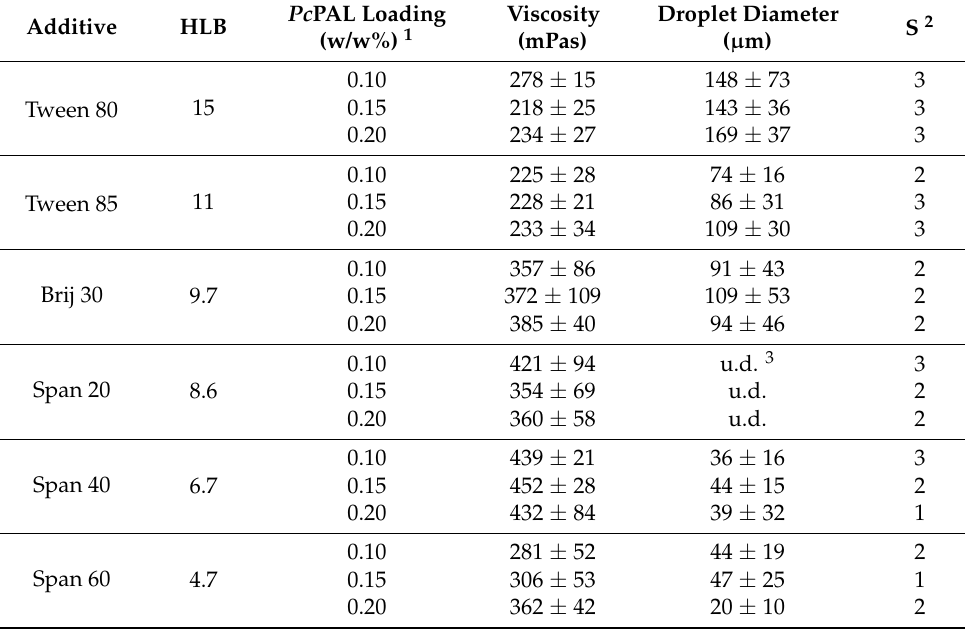
Table 2. The effect of the emulsifiers with different HLB values on the characteristic of precursor mixtures and the